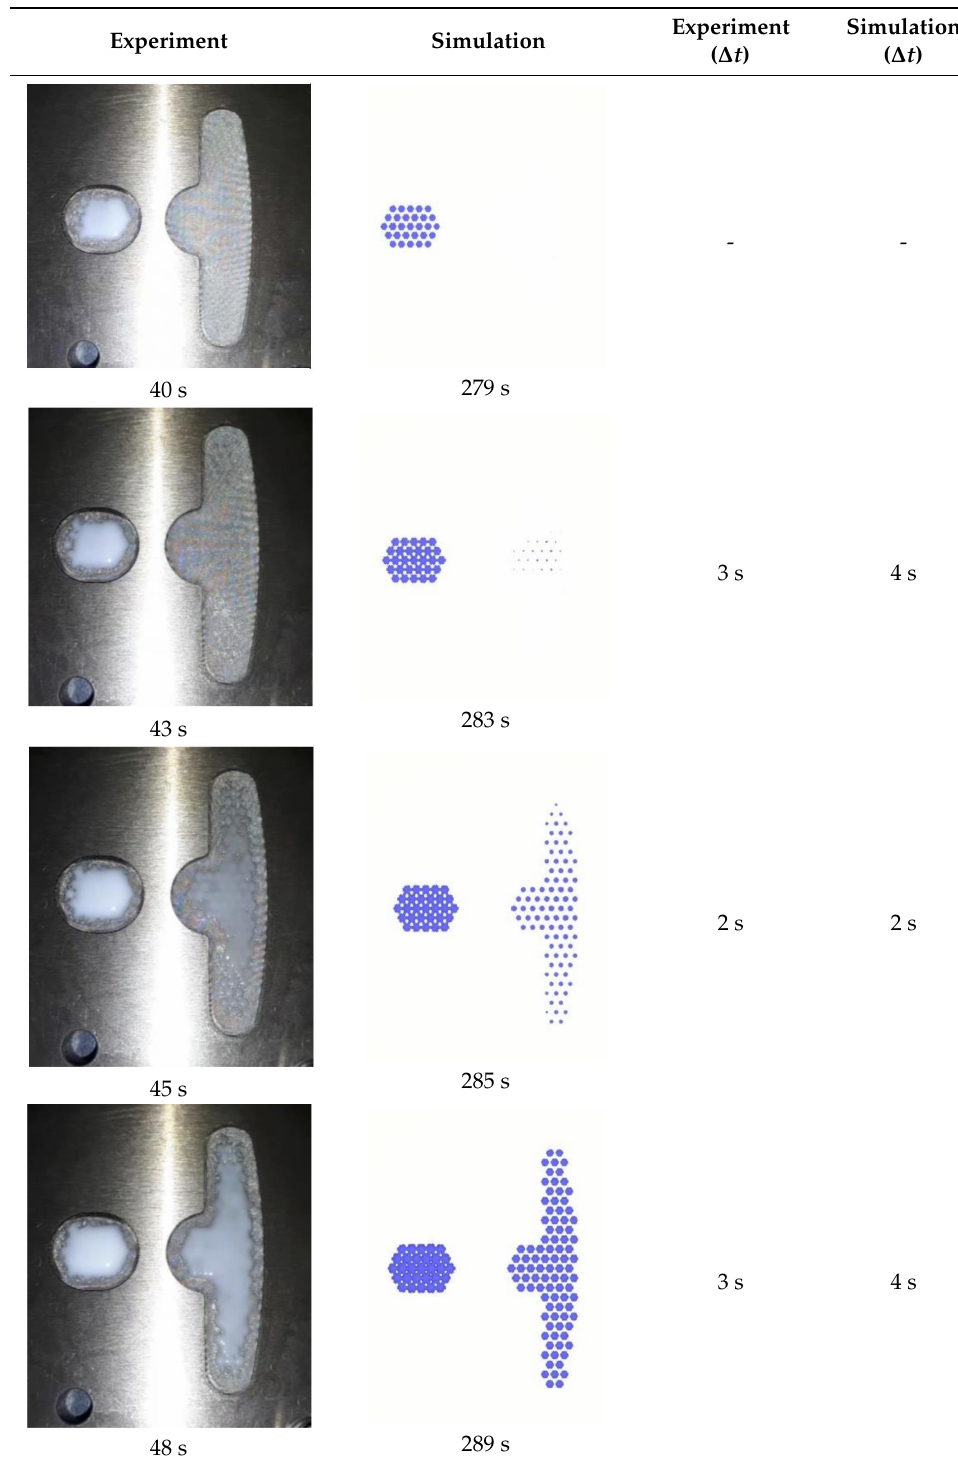
Table 5. Experiment and simulation results of flow trend in the plate. Since the filling process of the experiment is not easy to observe, there is a large gap in the total filling time. Therefore, the time difference is used to determine whether the trend is